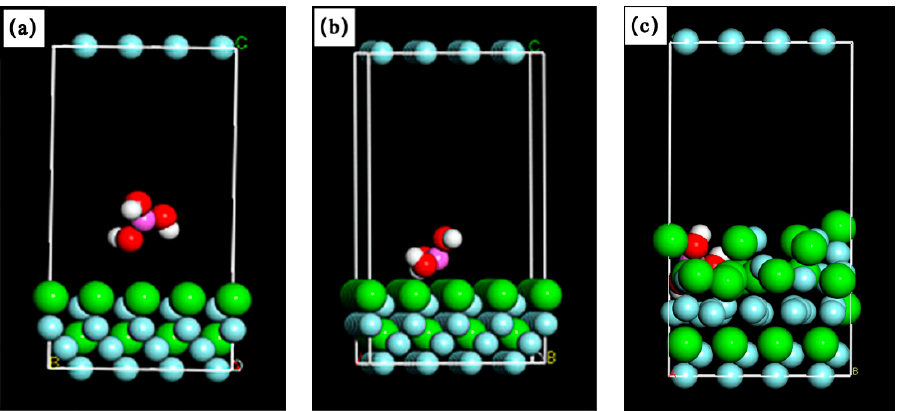
Figure 2. Adsorption process of Al(OH) 3 molecules on the CaF 2 surface: ( a ) before adsorption; ( b ) the surface is attached; and ( c ) fully